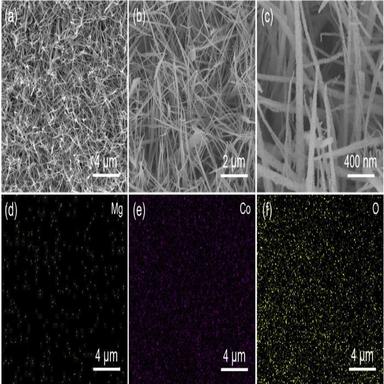
(a, b) Low- and (c) high-magnification SEM images of NF-supported MgCo2O4-NWs, and related EDX elemental mappings of (d) Mg, (e) Co, and (f) O collected from the same position in.